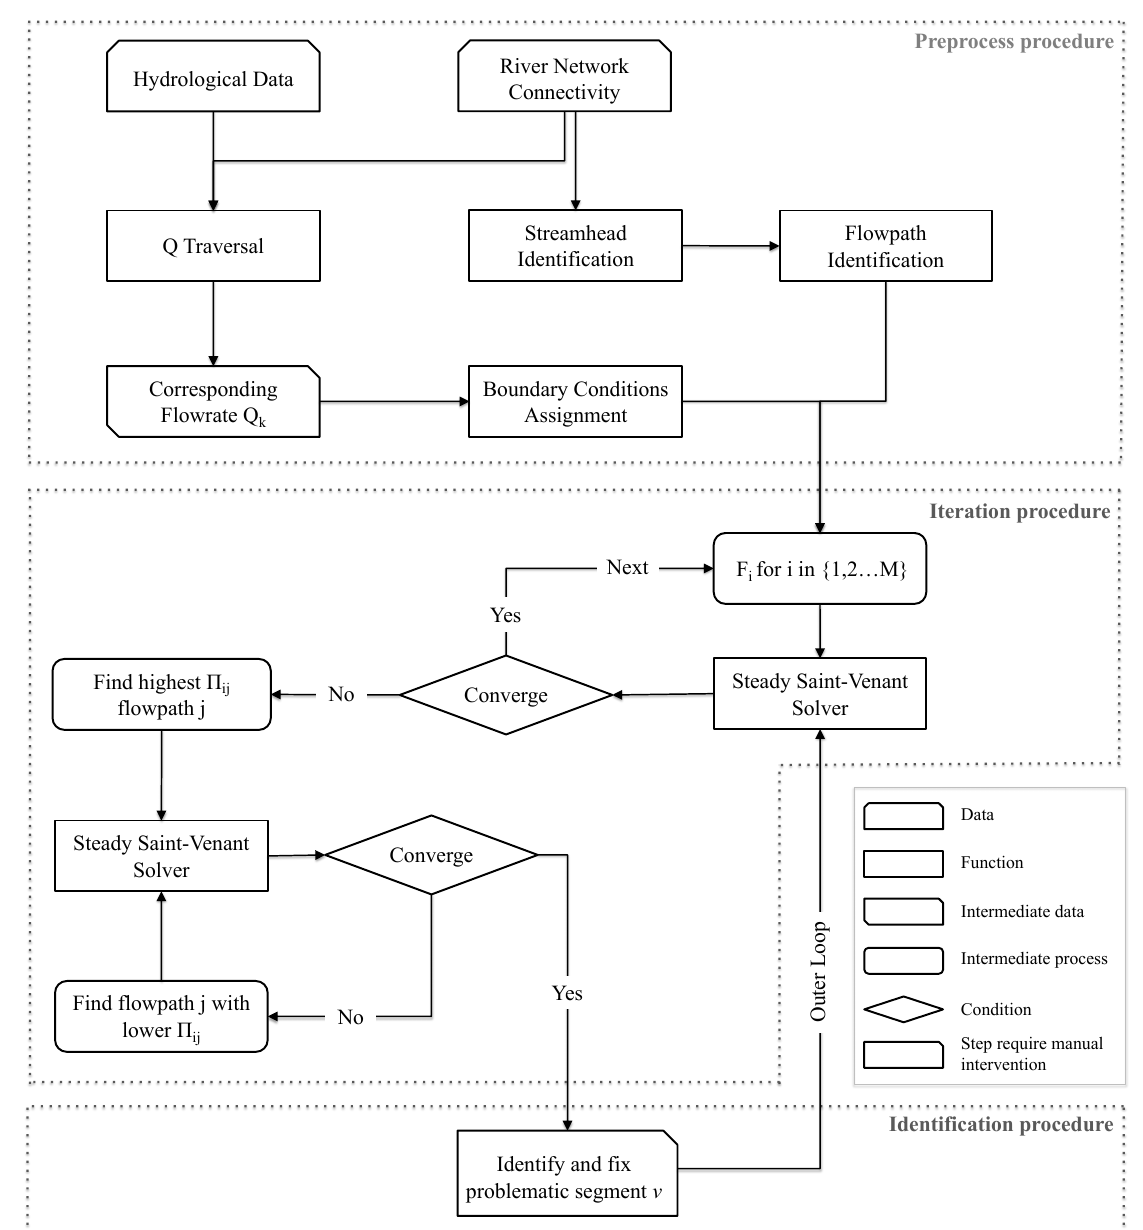
Figure 2. Flowchart of the SSA